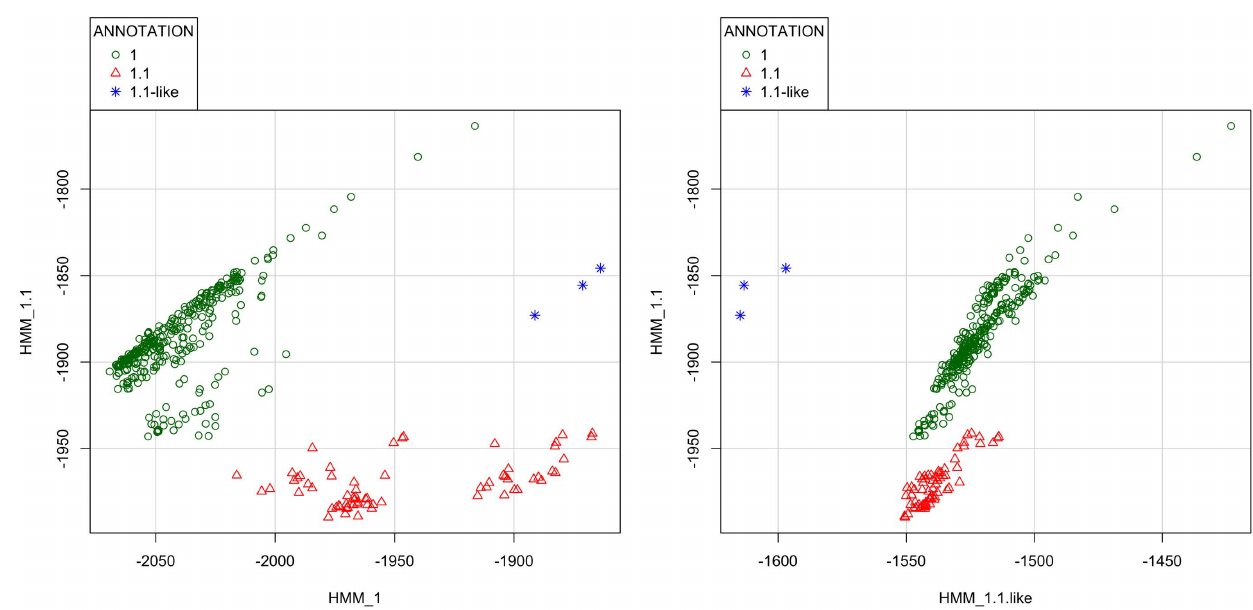
Figure 3. Two-dimensional scatterplots of profile HMM negative log-likelihood scores for H5N1 hemagglutinins in clades 1 (green circles) and 1.1 (red triangles) along with those in a 1.1-like group (blue stars). (A) Plot shows scores for the clade 1.1 -specific pHMM (Y-axis) versus scores for the clade 1 -specific pHMM (X-axis). (B) As in A, but with the X-axis containing scores for the 1.1-like pHMM instead. Smaller (more negative) numbers are considered better fits for that clade or group.